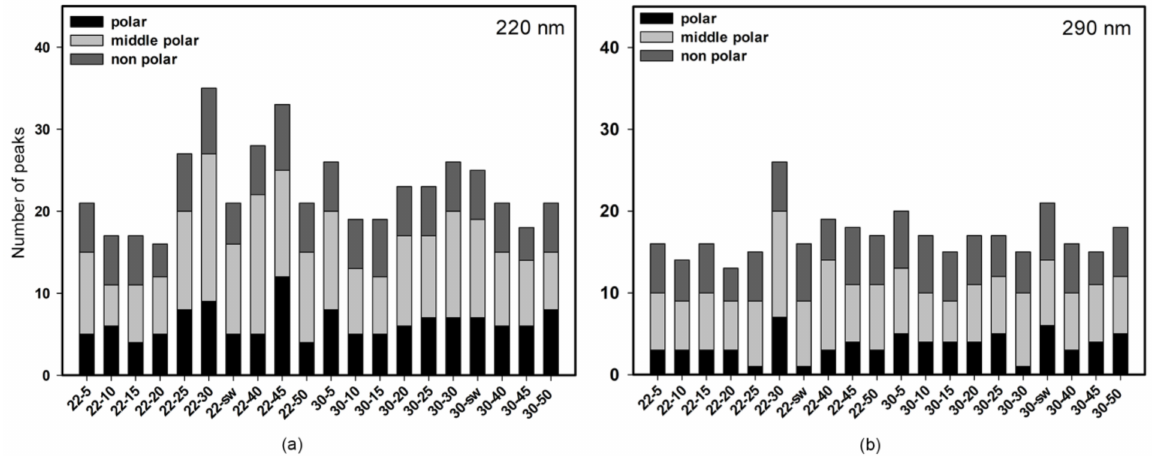
Figure 2. Total number of peaks in HPLC UV chromatograms. ( a ) Detection at 220 nm; ( b ) detection at 290 nm. The codes of extracts are presented in X axes of graphs.